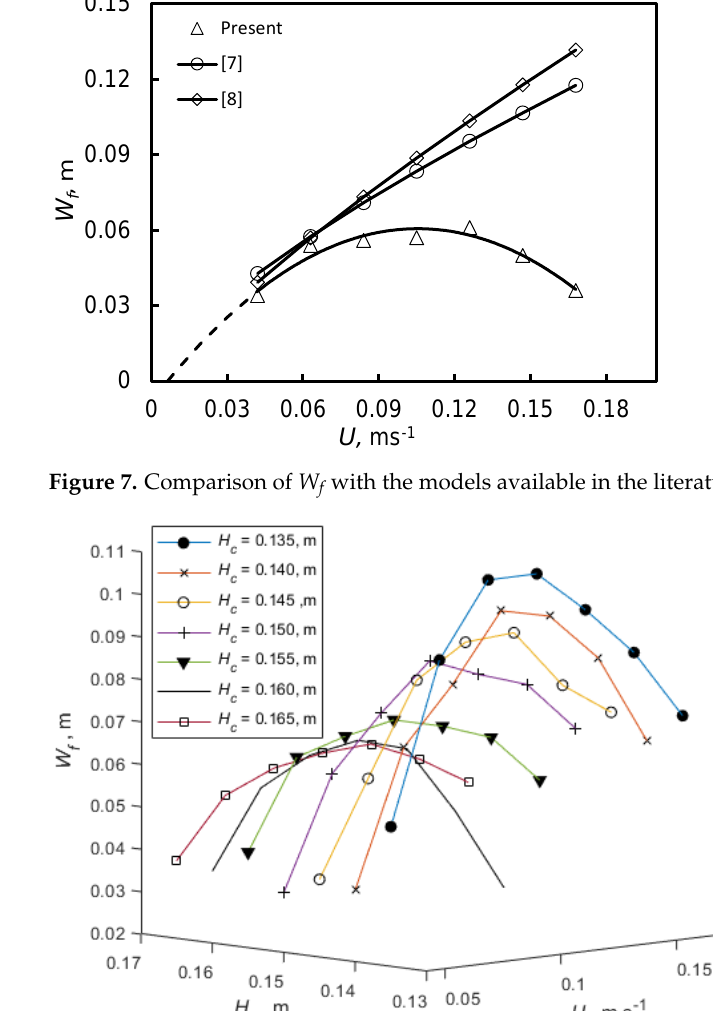
Figure 7. Comparison of W f with the models available in the literature.